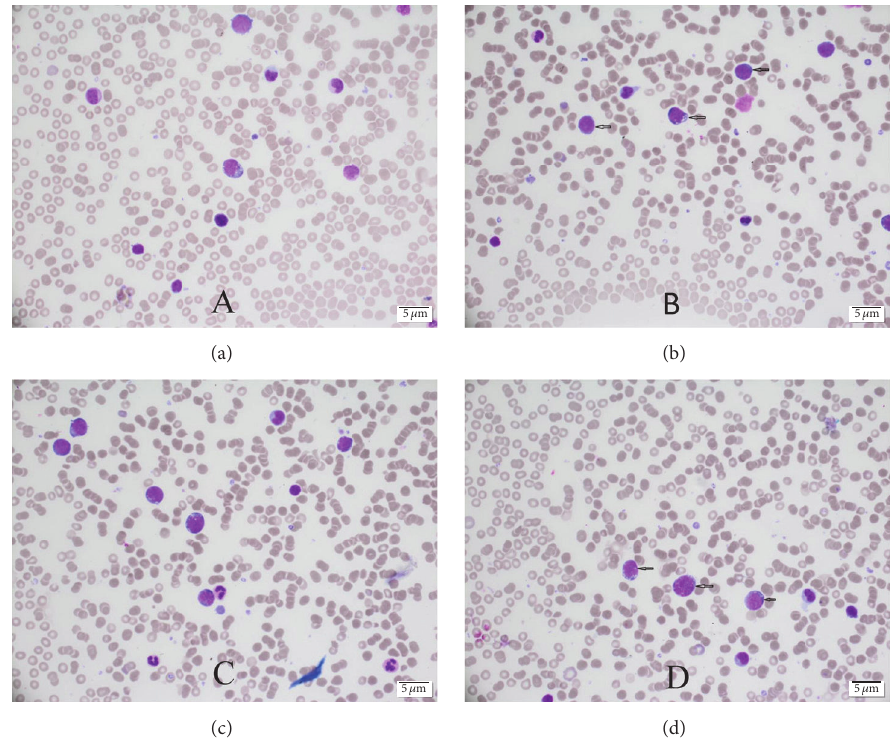
Figure 3: Bone marrow aspiration biopsy showing extensive (40%) infiltration by mononuclear cells with high nuclear :cytoplasmic ratio, basophilic cytoplasm, and cytoplasmic vacuolation (Burkitt’s lymphoma